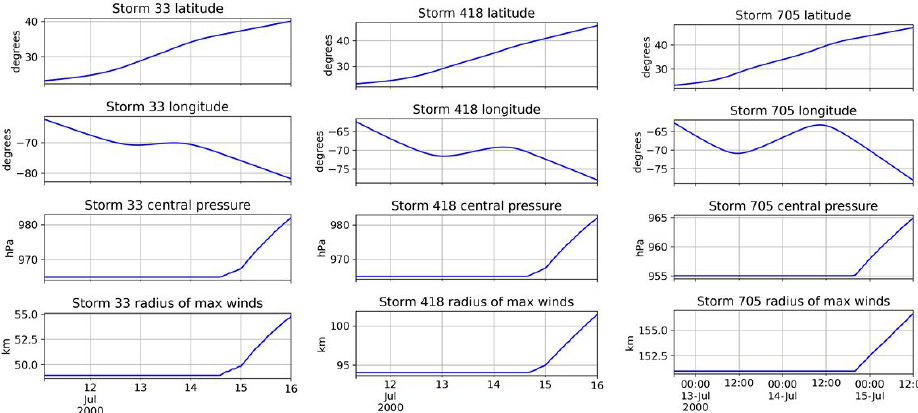
Figure 12. The time-series profiles of storm center (i.e., longitude and latitude), central pres- sure, and the radius of the maximum winds of the landfalling storms 33 ( left ), 418 ( middle ), and 705 ( right ).